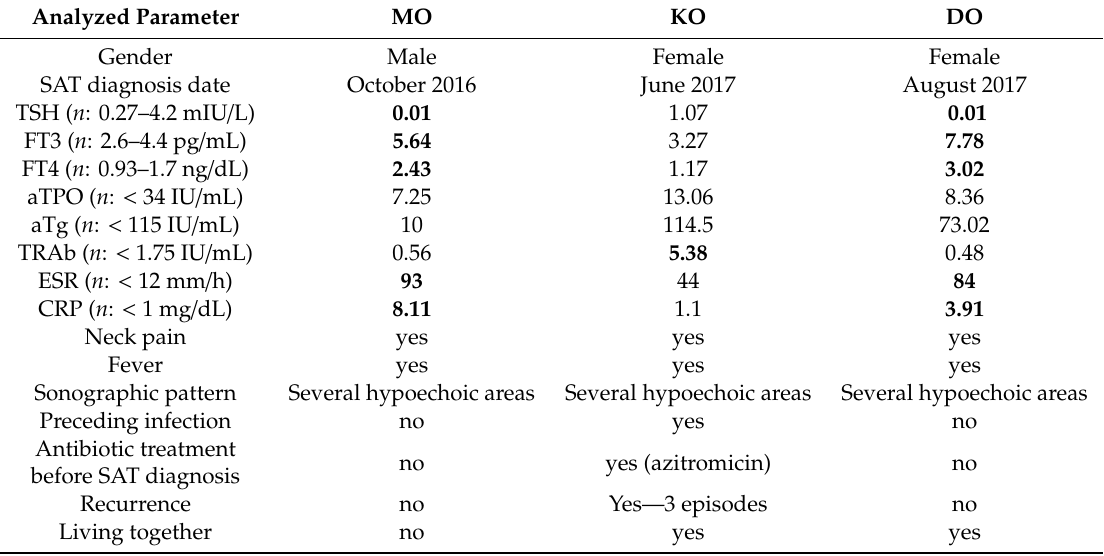
Table 1. Clinical characteristics and laboratory results at the subacute thyroiditis (SAT)